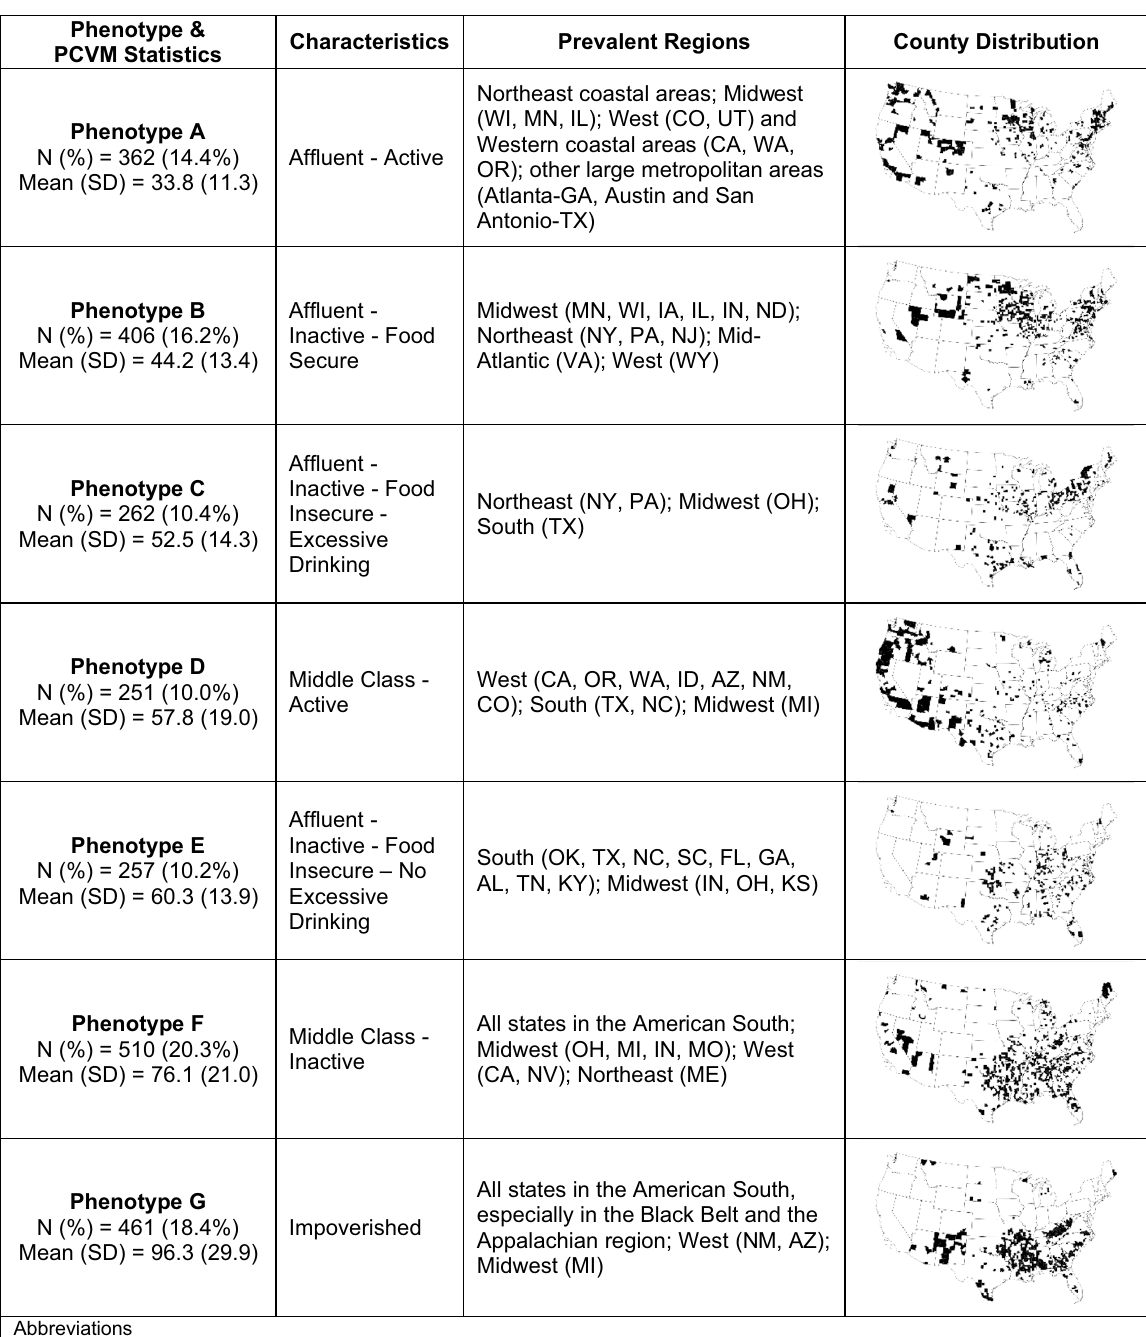
Figure 2. Characteristics of county premature cardiovascular mortality (PCVM) phenotypes identified by CART. Notes: Counties in training and test sets were both included. Maps were created by Python